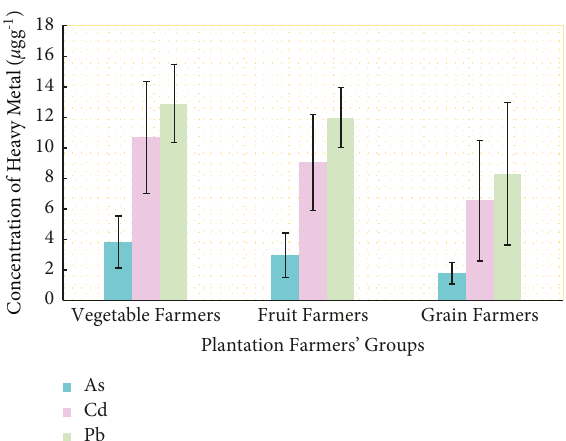
Figure 2: Concentration of studied metals in fingernails of farmers in various plantation farmers’ groups. Table 10: Concentrations of As, Cd, and Pb ( µ g g − 1 ) in farmers’ fingernail samples according to smoking habit. Heavy metal